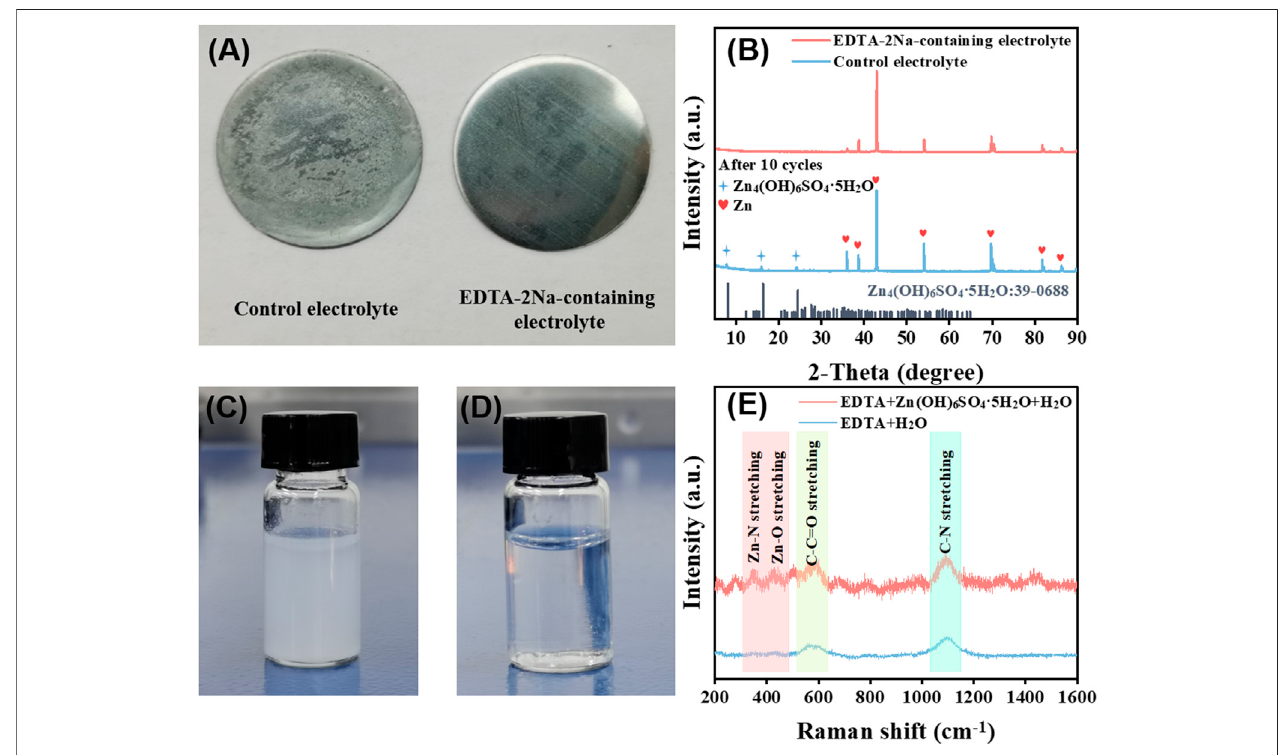
FIGURE 2 | (A) Image of Zn foil in control electrolyte and in EDTA-2Na-containing electrolyte. (B) XRD of Zn foil in control electrolyte and in EDTA-2Na-containing electrolyte. (C) Image of the Zn 4 (OH) 6 SO 4 .5H 2 O suspended in aqueous solution and (D) insoluble matter dissolution after adding EDTA-2Na. (E) Raman of solution before and after dissolving insoluble Zn 4 (OH) 6 SO 4 .5H 2 O with